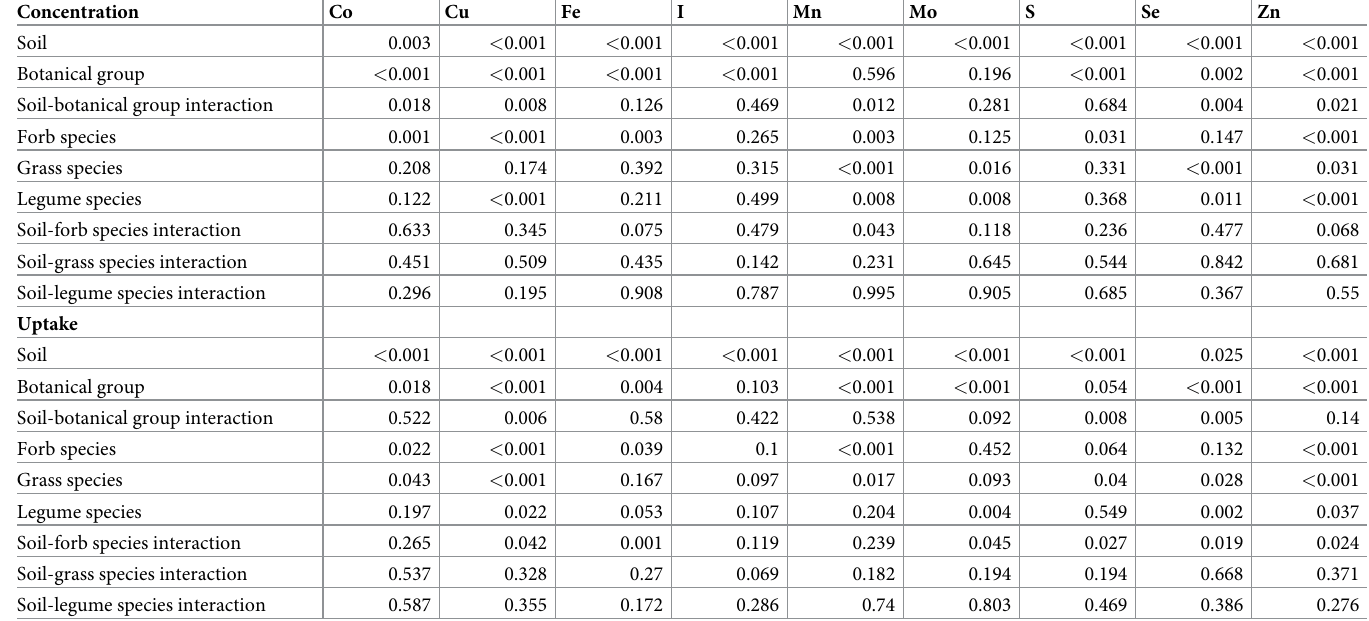
Table 2. Summary of the P values of the REML analysis for the concentration and uptake of each nutrient for soil, botanical group, plant species (within a botanical group) and the interaction of soil with each of